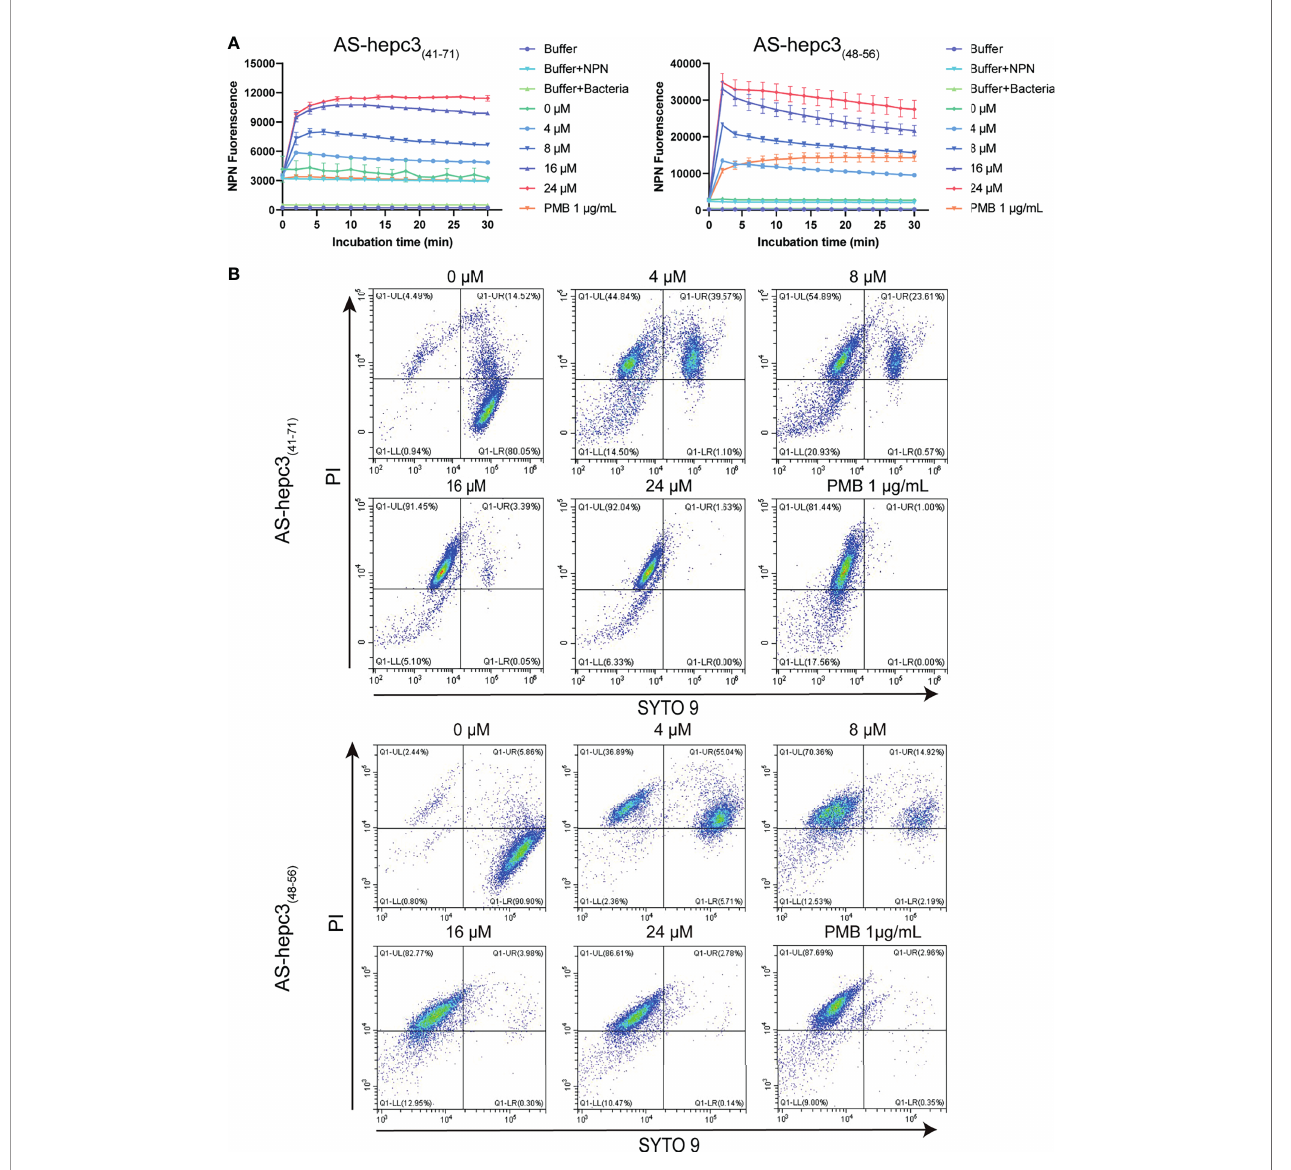
FIGURE 3 | Outer and Inner membrane permeability of PAO1 after the treatment of AMPs. (A) Outer membrane permeability after AS-hepc3 (41-71) or AS-hepc3 (48-56) treatment. The NPN fl uorescence was recorded at l ex = 350 nm and l em = 420 nm. (B) Inner membrane permeability after AS-hepc3 (41-71) or AS-hepc3 (48-56) treatment. PMB means polymyxin